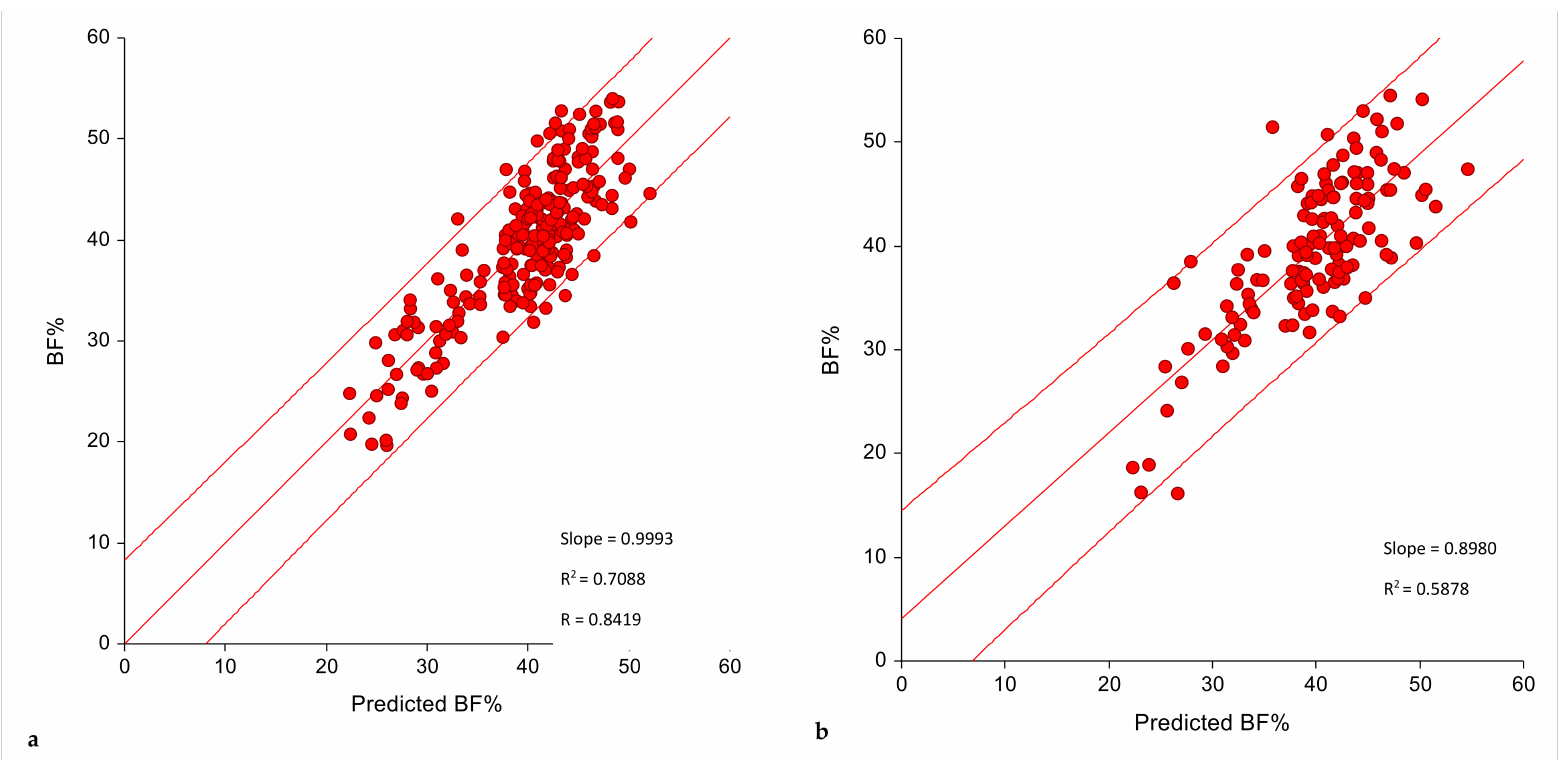
Figure 2. Calibration of prediction equation scatter plot of predicted vs. measured predicted BF% in the ( a ) training ( n = 238) and ( b ) validation ( n = 137) samples, model